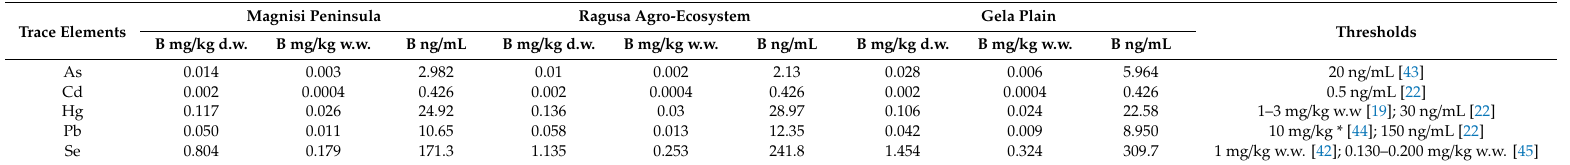
Table 2. Trace elements (mg / kg d.w.; results are also given in mg / kg w.w. and ng / mL for literature comparison) in the blood of the Stone Curlew, and the toxicological limits in other species. * The authors did not indicate if the threshold is expressed as d.w. or w.w. Trace